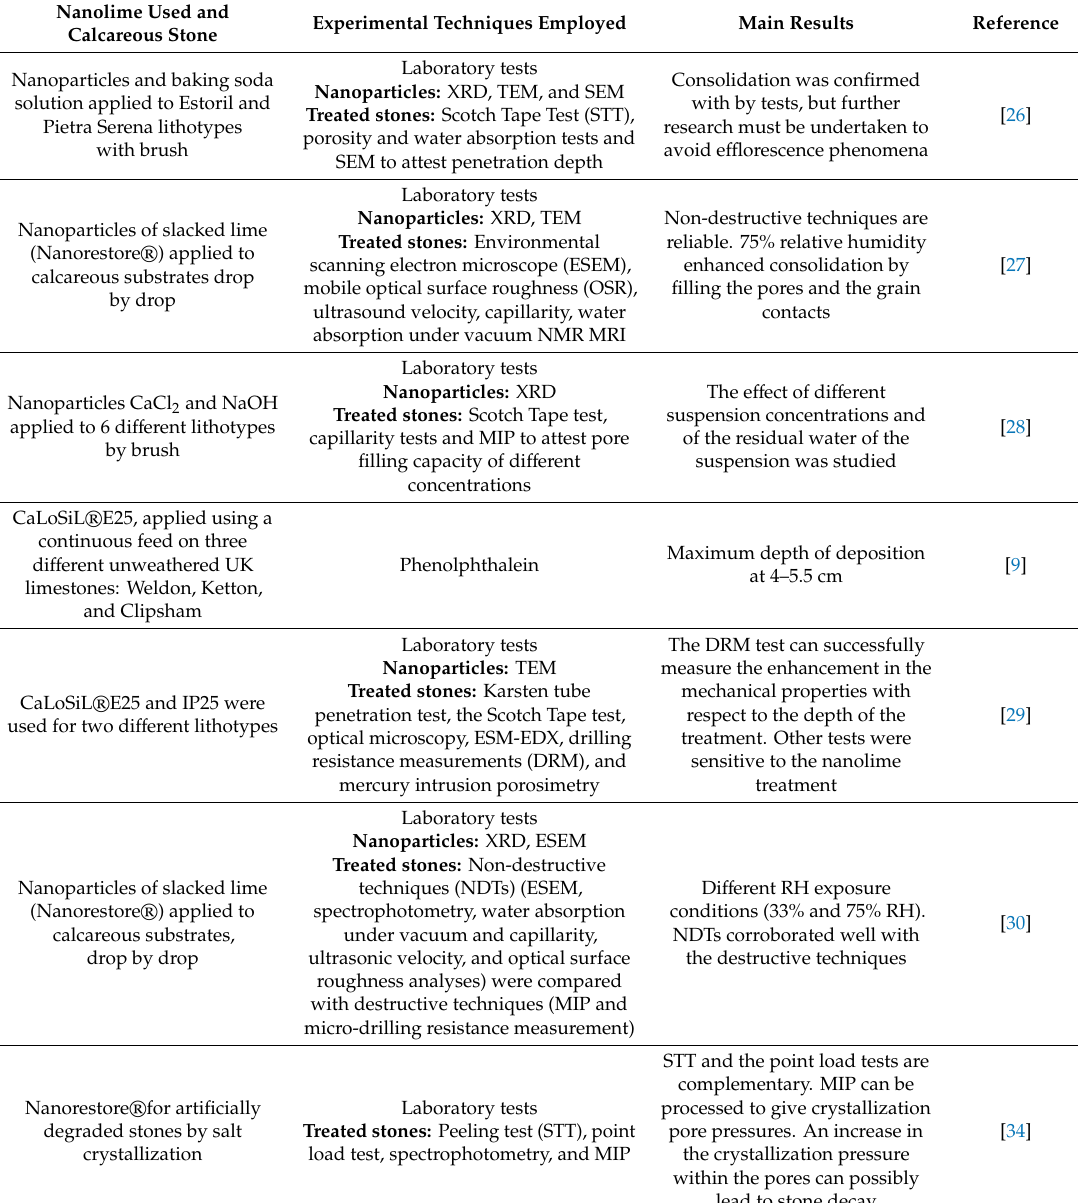
Table 2. Tabulated review of materials, experimental techniques, and main